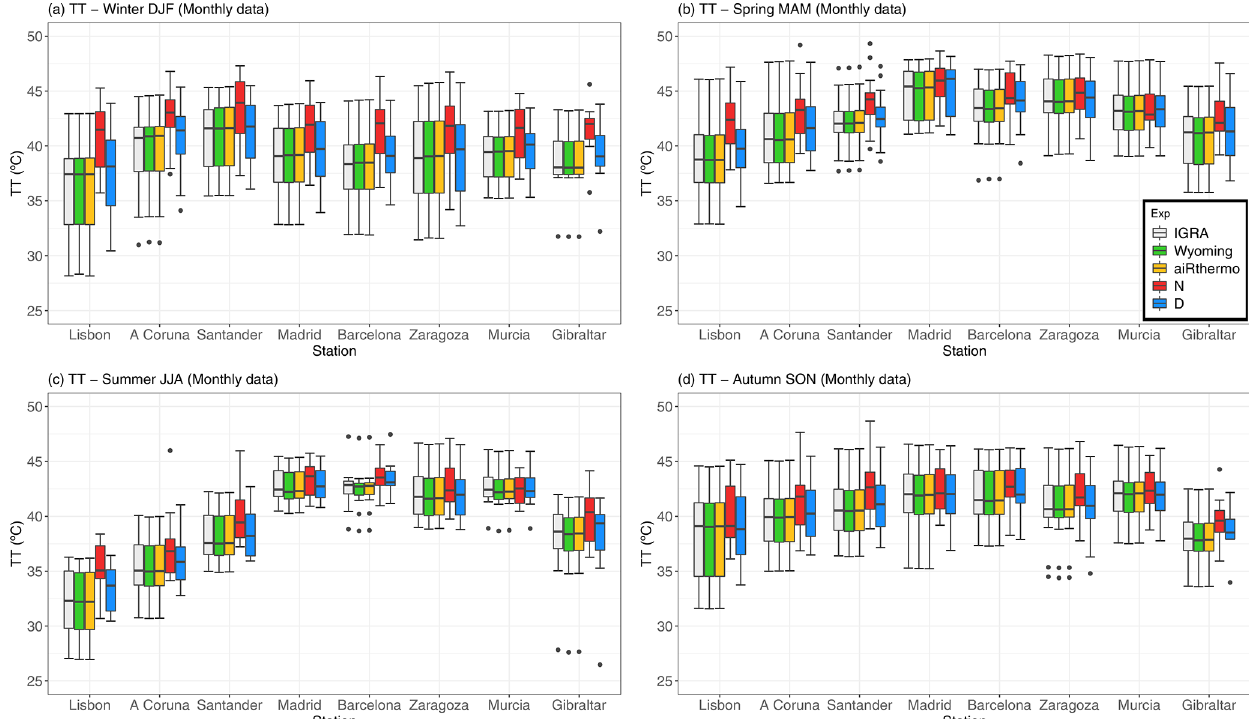
Figure 5. TT index for the reference data (grey), Wyoming (green), aiRthermo (orange), N (red), and D (blue), computed at each station for every season: winter (a) , spring (b) , summer (c) , and autumn (d)